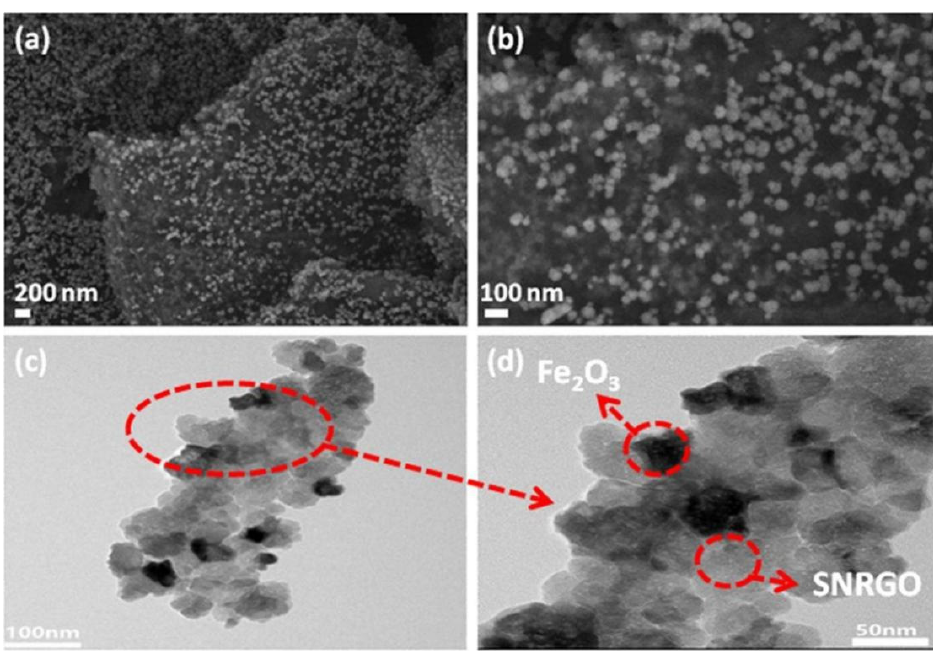
Figure 6. SEM images of ( a ) and ( b ) Fe 2 O 3 /SNRGO with different magnifications; TEM images of ( c ) and ( d ) Fe 2 O 3 /SNRGO with different magnifications. Reproduced with permission [56]. Copyright 2020, Elsevier.